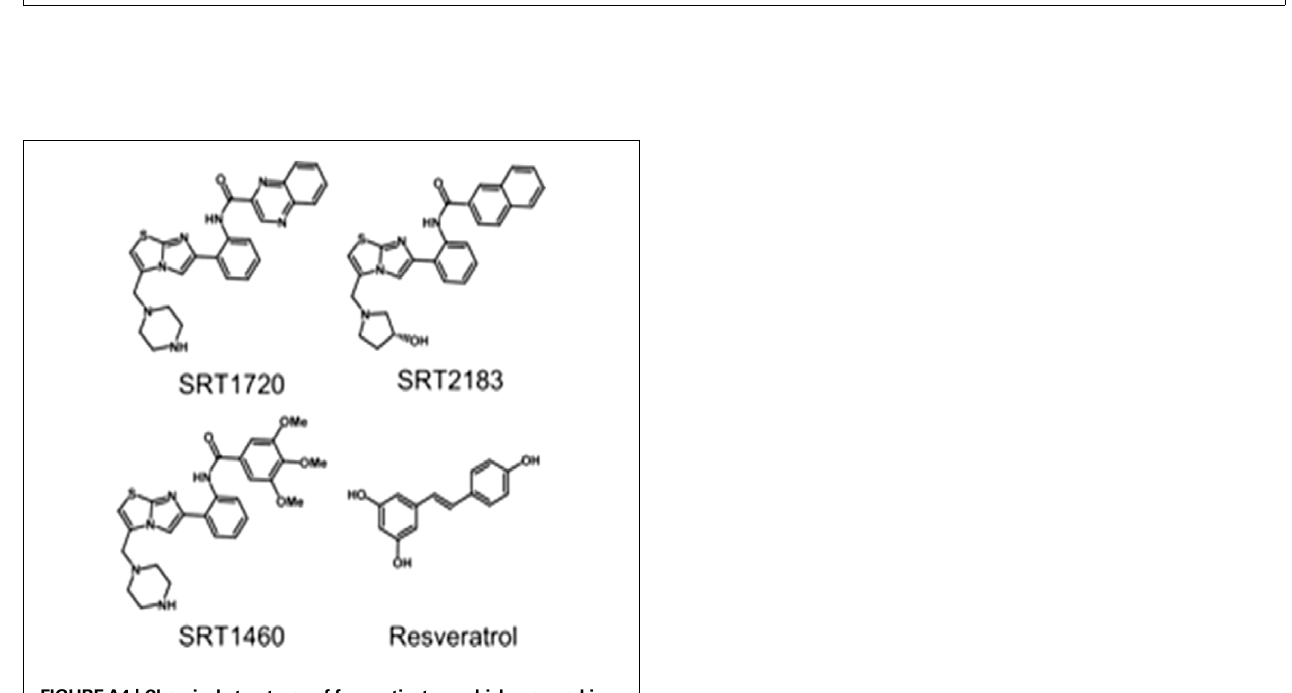
FIGUREA3 | Nodes in magenta represents the proteins involved in DNA bindingActivity whereas proteins involved inTranscription regulating activity in GO studies are represented in purple.